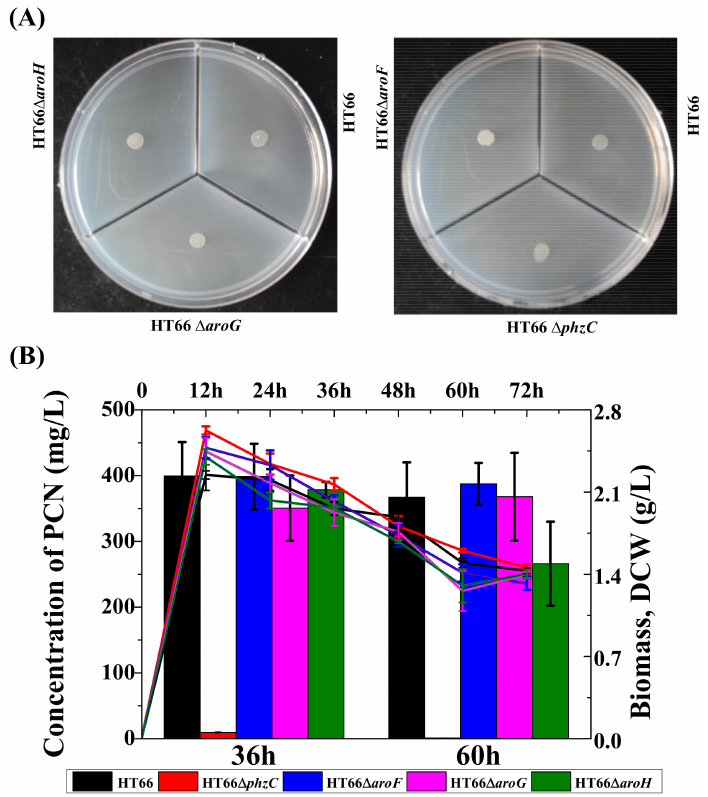
Figure 8. Photographs of P . chlororaphis HT66 derivatives grown on specific medium. ( A ) KB medium without tryptone, ( B ) KB medium without